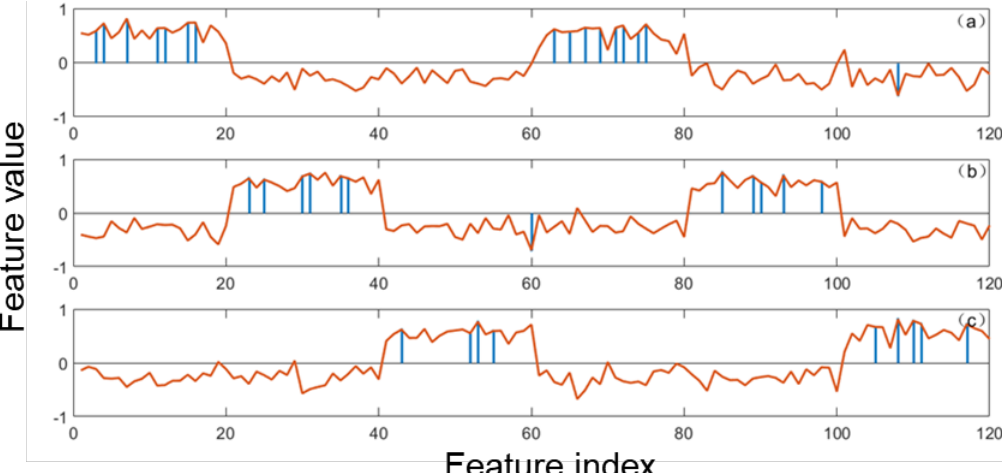
Figure 4. The selected class-specific features of dataset 1 by EPSVM: ( a ) treating class 1 as the positive class; ( b ) treating class 2 as the positive class; ( c ) treating class 3 as the positive class. Indicates the selected feature and indicates the average feature vector of one class.